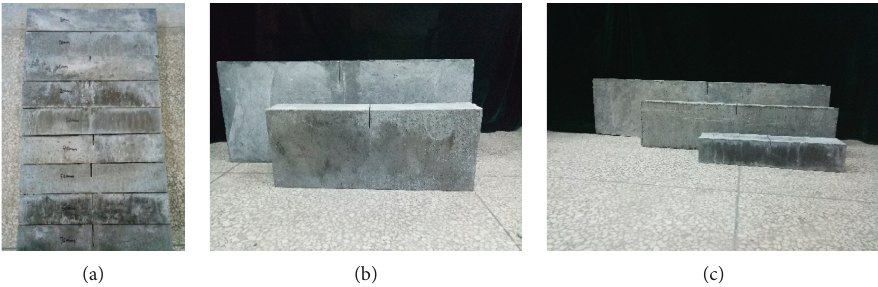
Figure 1: SENBs with different sizes. (a) Small size with S / W � 4. (b) Large size with S / W � 2 . 5. (c) Geometrically similar specimens with S / W � 4.